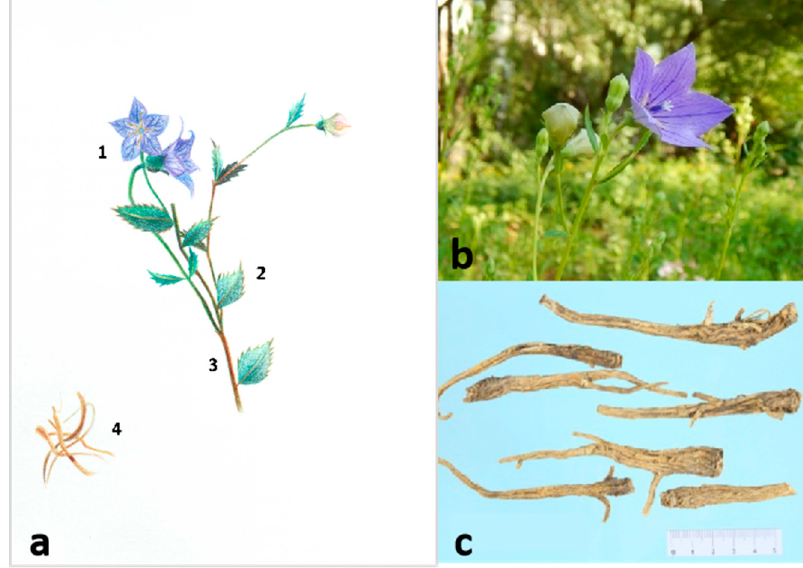
Figure 1. Images of P. grandiflorus . ( a ) Line drawing of P. grandiflorus : 1. flower; 2. leaf; 3. stem; 4. root. ( b ) Plant of P. grandiflorus . ( c ) The medicinal material of P. grandiflorus .